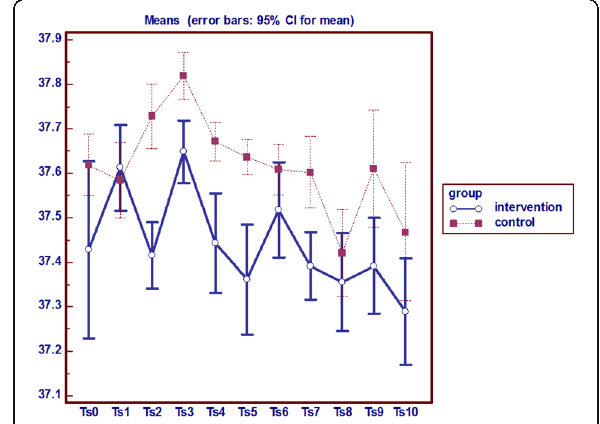
Fig. 5 Analysis of variance with repeated measures on the Pain of Sacrum